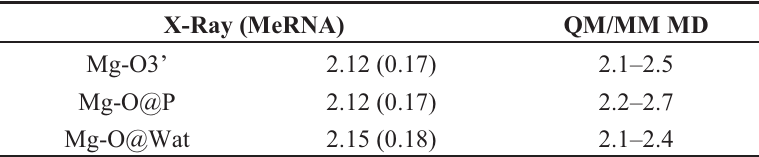
Table 3. Average bond lengths (Å) of Mg(II) ions and the coordination ligands obtained from the MeRNA database [161] and from other QM/MM studies